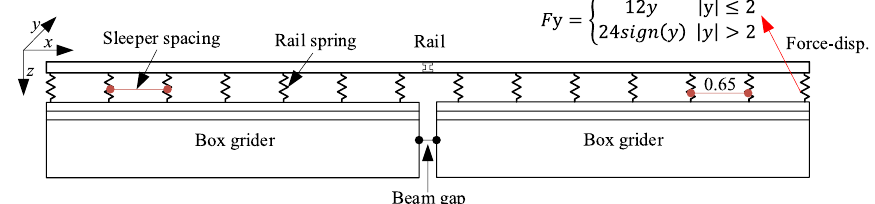
Fig. 9 Beam model with discrete point